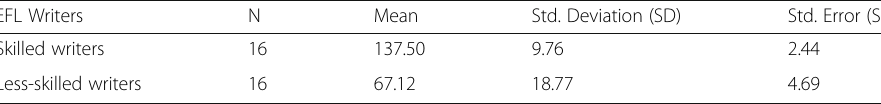
Table 3 Descriptive statistics of MARQ by